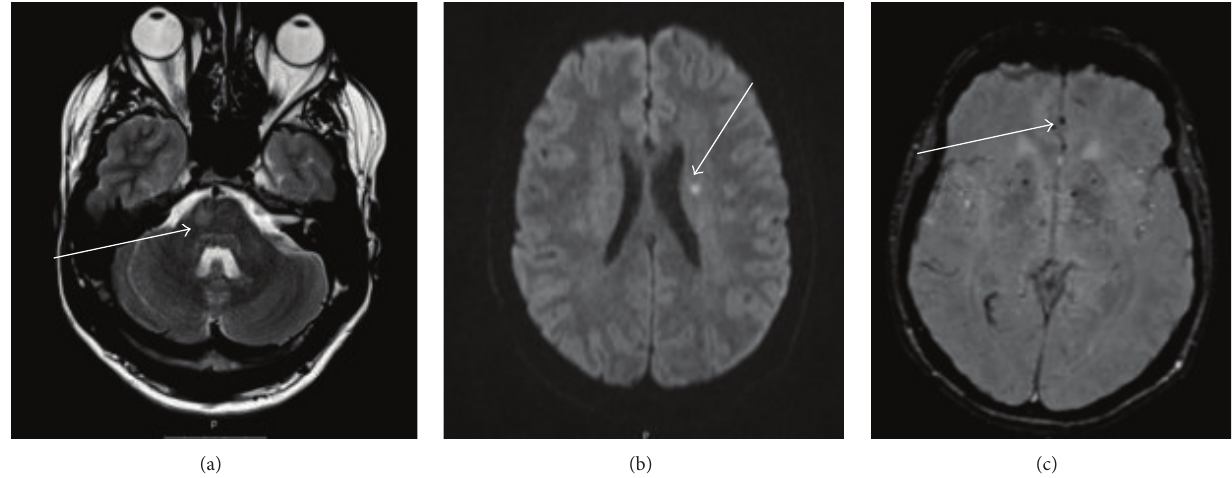
Figure 1: MRI scan of brain. MRI of brain. Axial T2-weighted image showing T2 hyperintense lesion within the right pons (arrow) (a). Axial DWI (B1000) demonstrates restricted diffusion within the left centrum semiovale (arrow) (b). Gradient recalled ECHO T2 susceptibility weighted imaging showing diffuse hypointense lesions suggestive of microhaemorrhages (arrow) (c).